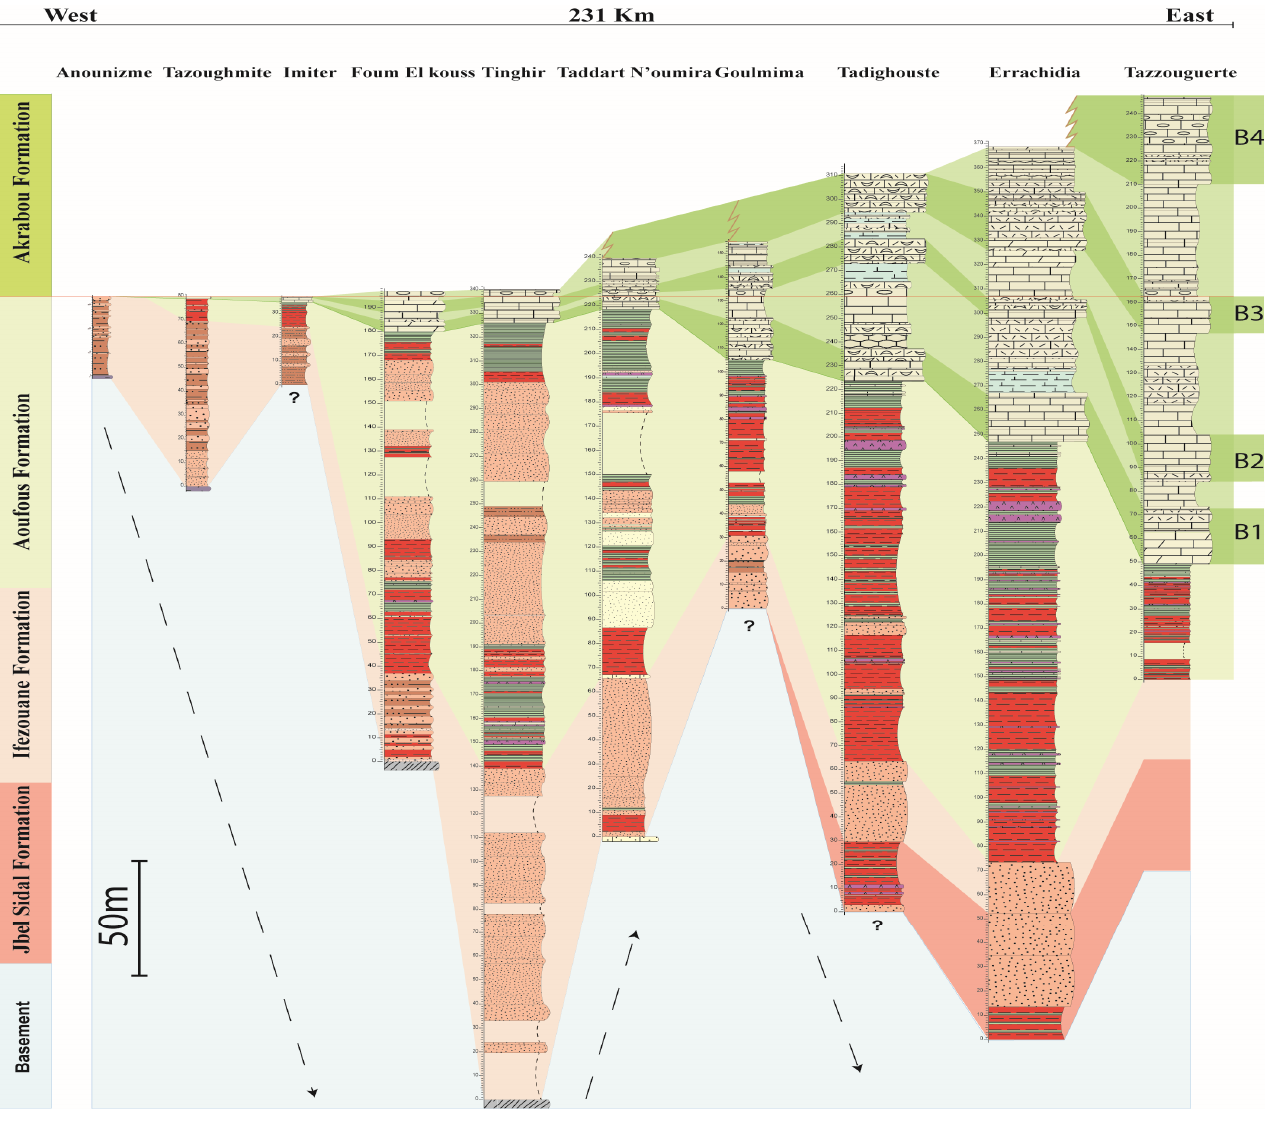
Figure 14. Diagram showing the lithostratigraphic correlation of the studied sections along a west ‐ east transect in the Errachidia–Boudnib–Erfoud Basin.